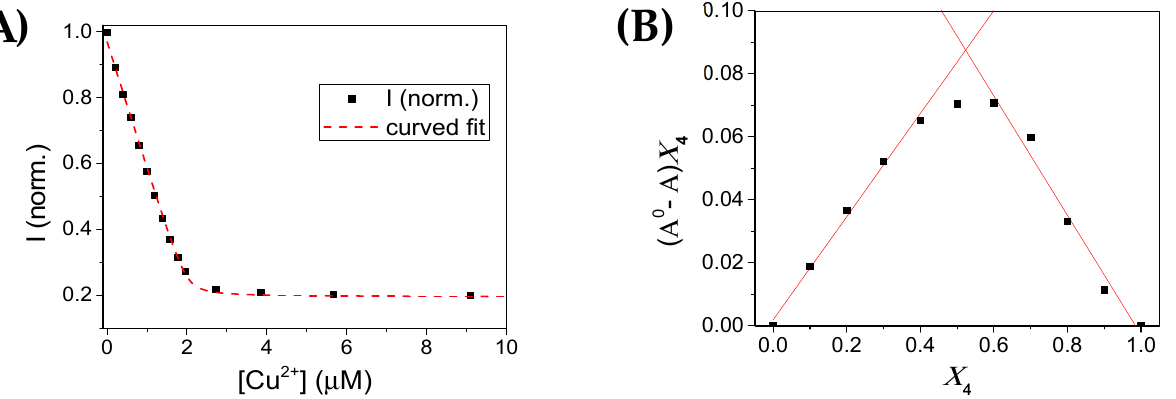
Figure 6. ( A ) Emission changes of 4 (2.5 μ M), in a 50:50 mixture of methanol and 0.01 M HEPES buffer at pH = 7.1 ( λ EXC = 500 nm), in the presence of Cu 2+ . ( B ) Job’s plot for continuous variation in [ 4 ] vs. [Cu 2+ ]. The intersect between the slopes of the linear fits (red lines) was at 0.52 for the molar fraction of 4 (X 4 ).